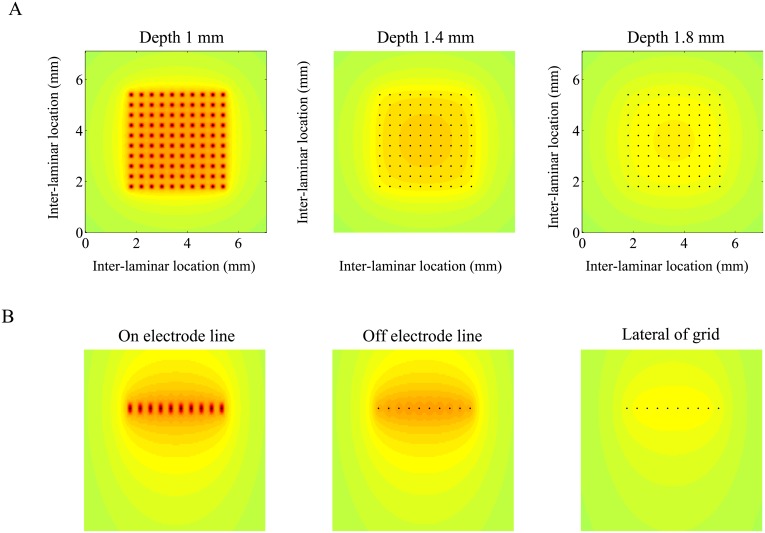
Sensitivity of the Utah leadfield matrix.A. Sensitivity profile of the leadfields along three intra-laminar (horizontal) slices at different cortical depths (left: 1 mm, middle: 1.4 mm, right: 1.8 mm). The Utah array is located at a depth of 1 mm. B. Sensitivity profile of the leadfields along three vertical slices at different lateral locations (left: through the center of the array and on the electrode line, middle: through the center of the array and off the electrode line, right: 200 μm lateral to the array). In all panels, the same color-scaling has been applied so that the sensitivities can be directly compared. Green and red correspond to low and high values, respectively. Black dots in A and B denote the electrodes of the 10 × 10 Utah electrode array (400 μm inter-electrode spacing).